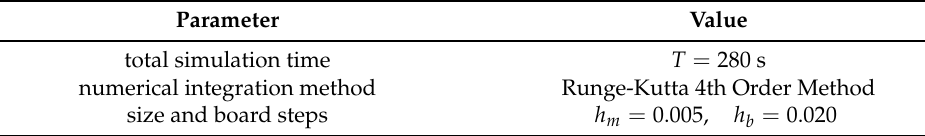
Table 1. Simulation parameters.